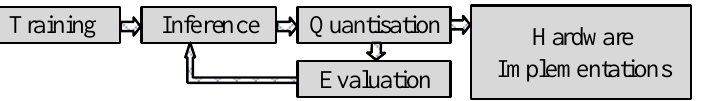
Figure 2. The HH-NIDS framework’s processing flow from training to hardware